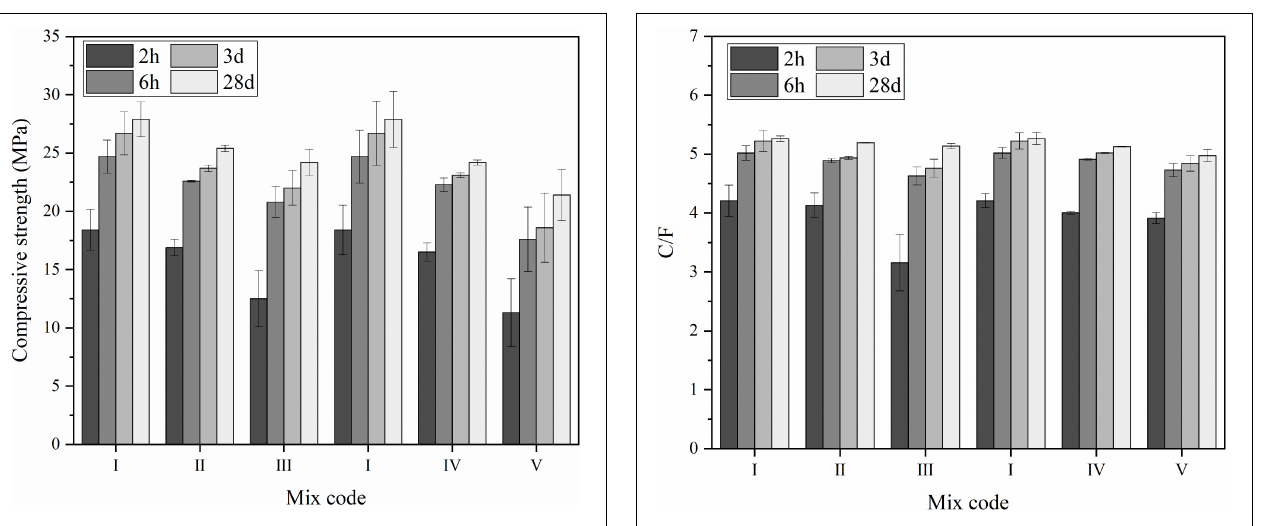
FIGURE 2 | Compressive strength of CAEM.